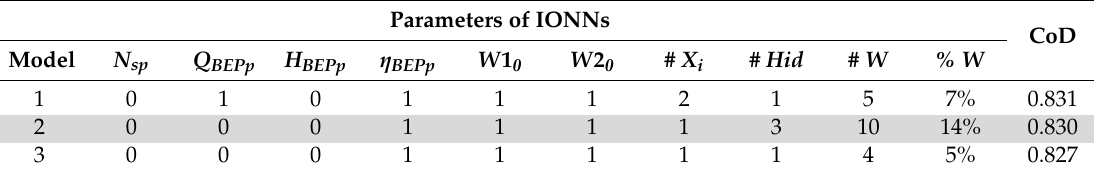
Table 5. Pareto front (min(neurons, inputs, 1 − CoD)) of IONNs for η BEPt .